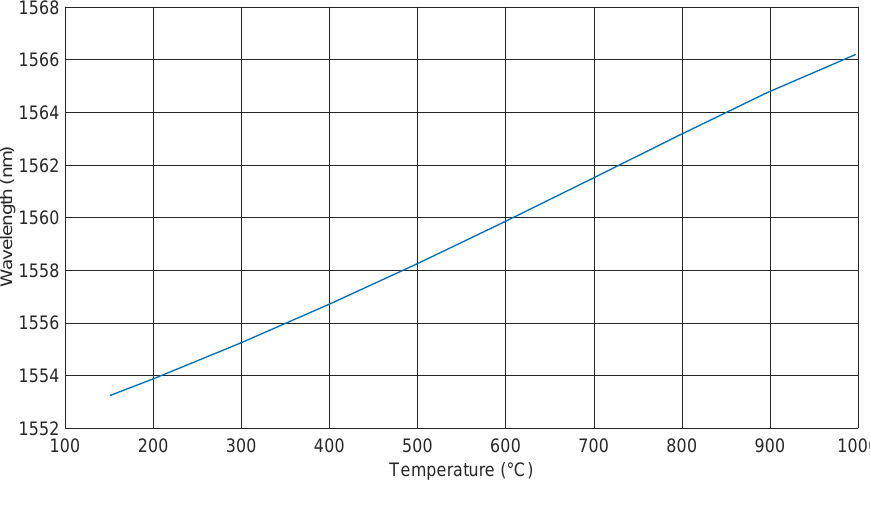
Figure 2. Temperature calibration curve of a regenerated FBG in a GF1B fibre.